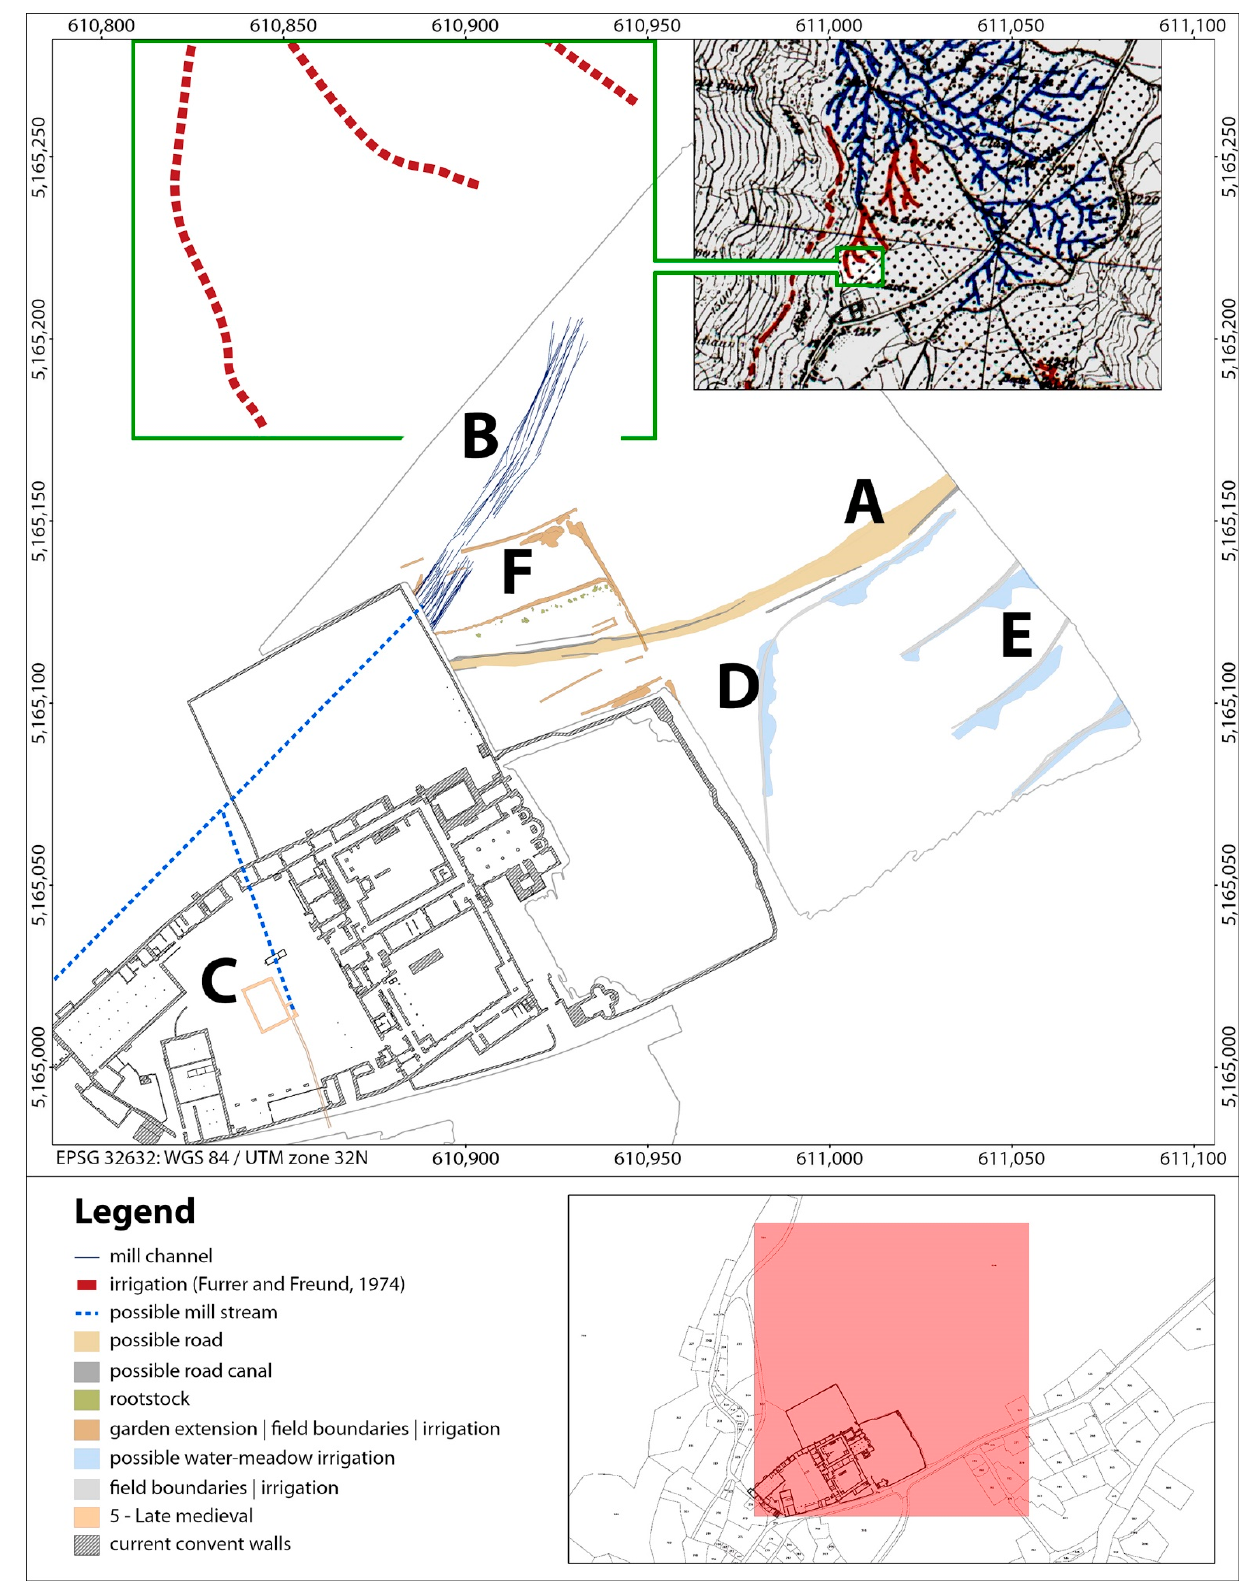
Figure 5. Overview of the known historical structures and the new prospection results in area 1 (see the text for the capitalised characters, A – F ). The upper right insert shows a part of the map mentioned in Furrer and Freund [9].